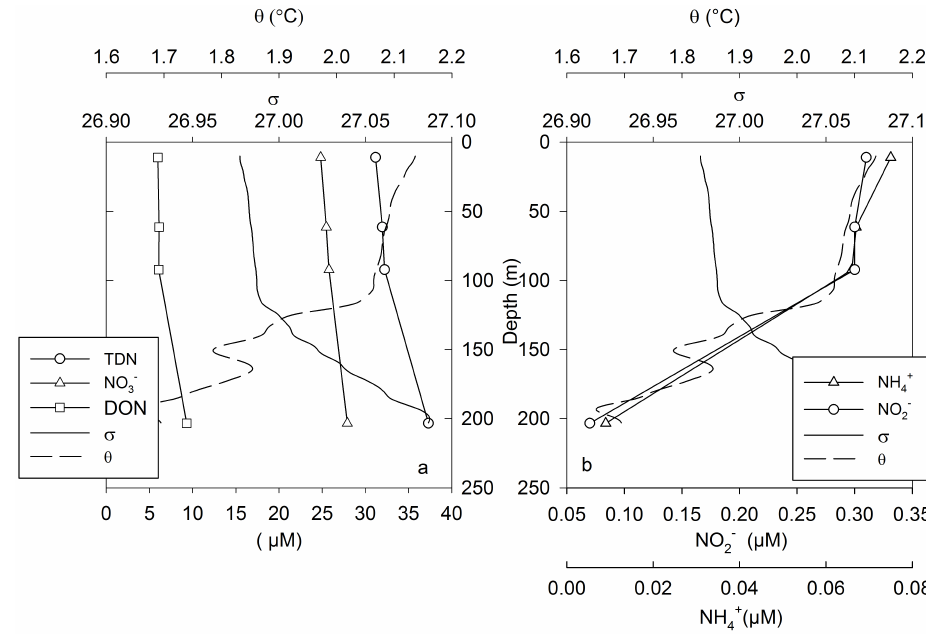
Figure 6. Dissolved nitrogen speciation at station R-2.